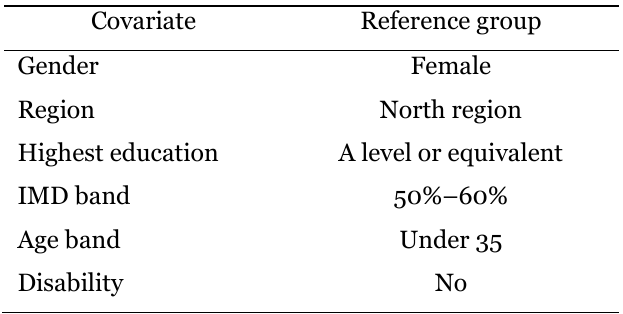
Reference Groups for the Computation of the Cox Model